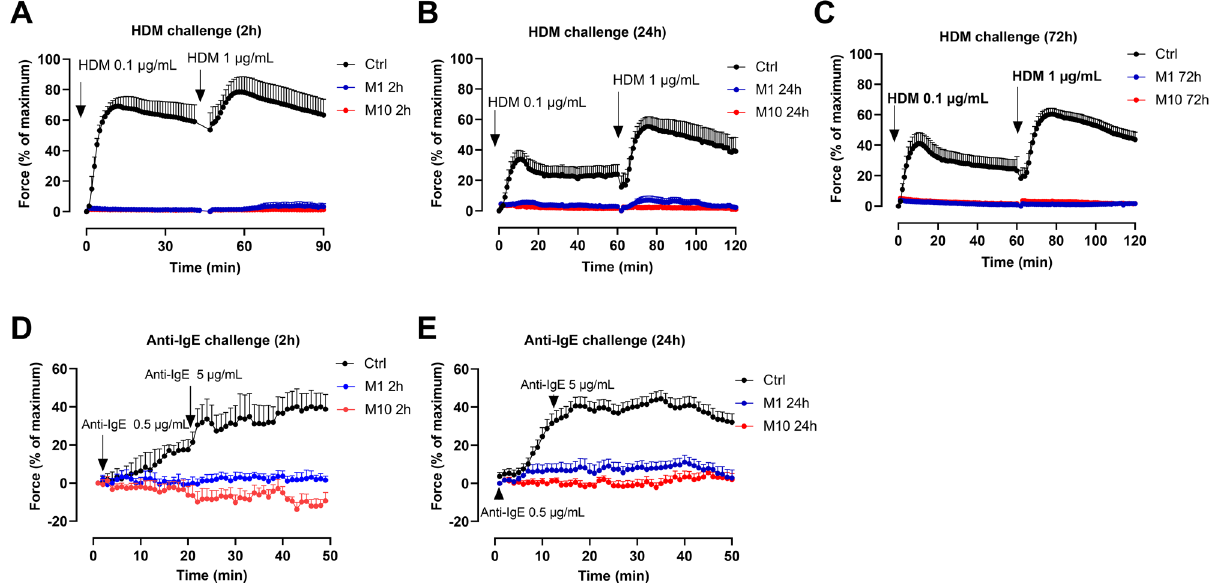
Figure 5. Responses of guinea pig trachea to HDM and human bronchi to anti-IgE after monensin exposure. The responses of guinea pig tracheal segments to HDM after culturing with 1 µM (M1) or 10 µM (M10) monensin, or vehicle (1% ethanol; Ctrl) for ( A ) 2 h, ( B ) 24 h and ( C ) 72 h (n = 3–8 per group). The responses of human bronchi to anti-IgE after ( D ) 2 h and ( E ) 24 h incubation (n = 5–13 per (Fig. 4B and D). In contrast, segments exposed to 10 µM monensin displayed both a delayed and reduced reac- tion to histamine, with a shift of pEC 50 from 6.1 and 6.3 in the controls to 5.1 and 5.4 together with a decrease of maximal contraction (Emax) from 84 ± 9 and 96 ± 2% to 25 ± 11 and 19 ± 13% after 24 h and 72 h monensin exposure (Fig. 4B and D). Tissue viability of human bronchi, reflected as responses to carbachol, was not diminished after exposure to monensin (Fig. 4E). As for the histamine response, instead of causing desensitization of the histamine H 1 recep- tor, exposure to 10 µM monensin significantly potentiated the histamine response, with a change of pEC 50 from 6.8 in the control group to 7.2 in the treated group (Fig. 4F). Monensin exposure blocked HDM- and anti-IgE induced bronchoconstriction. To investigate whether monensin interferes with MC function, HDM challenges (0.1 µg/mL and 1 µg/mL) were performed in guinea pig tracheal segments after 2–72 h monensin treatment. In control segments (for the 2 h exposure), HDM (0.1 µg/mL) induced a strong smooth muscle contraction, reaching 69 ± 6% of the maximum, which was further increased to 79 ± 10% when, additionally, 1 µg/mL monensin was added. No contraction could be detected in the segments pre-exposed to either 1 or 10 µM of monensin for 2 h (Fig. 5A). The contractions induced by HDM (0.1 µg/mL and 1 µg/mL) in the controls reached 34 ± 6% and 55 ± 6% (after 24 h culture) or 41 ± 7% and 60 ± 4% of maximum (after 72 h culture), respectively. However, the antigen-induced contractions were completely abol- ished after incubation with monensin (1 or 10 µM) for both 24 h and 72 h (Fig. 5B and C). To study the effect of monensin on MC-related bronchoconstriction in human airways, anti-IgE antibodies (anti-IgE), which bind to IgE at the high affinity IgE receptor on MCs and thereby cause MC activation, were used 11 . As seen in Fig. 5D, 0.5 µg/mL anti-IgE evoked a smooth muscle contraction in control segments (22 ± 5% of maximum) which was further enhanced by 5 µg/mL anti-IgE (40 ± 10%). In contrast, 2 h pre-treatment with either 1 or 10 µM monensin completely prevented the anti-IgE induced constriction (Fig. 5D). Similarly, no bronchoconstriction was detected in tissues treated with either 1 µM or 10 µM monensin for 24 h (Fig. 5E). Repeated intranasal dosages of monensin reduced AHR, airway inflammation and mast cell hyperplasia in a guinea pig asthma model. To investigate the effect of monensin in vivo, a guinea pig asthma model based on HDM exposures was established (Fig. 6A). Compared to the naïve animals, the HDM sensitized animals demonstrated enhanced responses to methacholine after three weeks challenges in the New- tonian resistance (reflecting resistance in conducting airways; Rn ; Fig. 6B), tissue damping (reflecting resistance in peripheral lung; G ; Fig. 6C) and tissue elastance (peripheral elastance; H ; Fig. 6D). However, all the increases were found reduced after pretreatment with monensin (Fig. 6B–D). The exaggerated methacholine responses could also be found after challenges with HDM for five weeks. These increases were also be dampened by mon- ensin (Fig. 6E–G). The effect of monensin on airway inflammation was examined in the lung sections stained by Hematoxy- lin–Eosin from animals received HDM challenges for five weeks. As shown in Fig. 7A, a significant increase of inflammatory area was found in HDM exposed animals. This increase was alleviated by monensin.